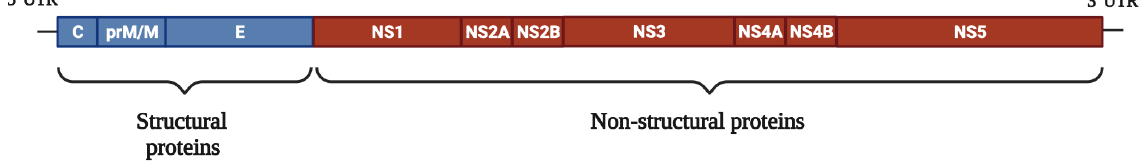
Figure 1. DENV RNA genome organization. The DENV positive-sense RNA genome consists of 11 kilobases (kb) with a single open reading frame (ORF) characterized by the presence of two untrans- lated regions (UTRs) at both ends of the ORF. The 5′ -UTR consists of 95–135 nucleotides with a type I cap- like mRNA whereas the 3′ -UTR consists of 114–650 nucleotides and lacks a poly(A) tail, ending in a conserved stem-loop secondary structure [23,24]. The figure was created using Biorender.com (ON, Canada) (accessed on 26 February 2023).